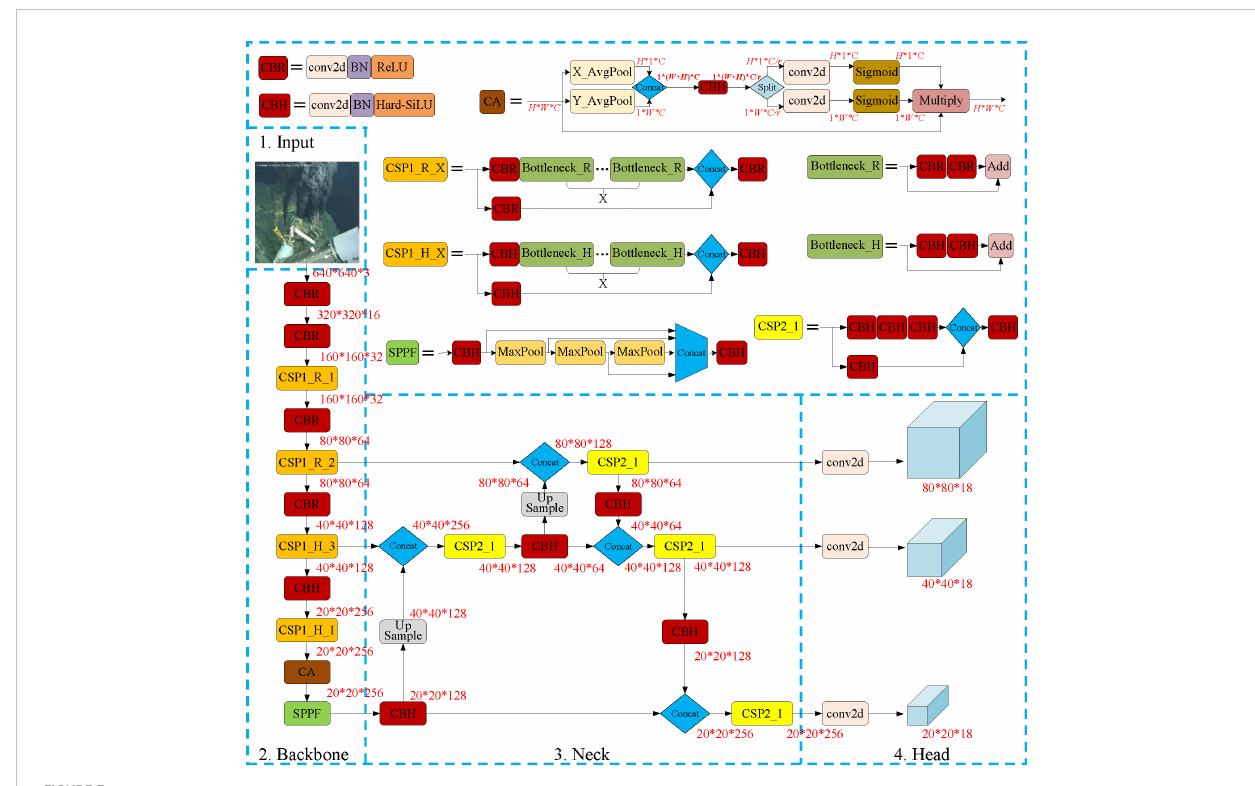
FIGURE 3 Network structure diagram of the proposed hydrothermal plume